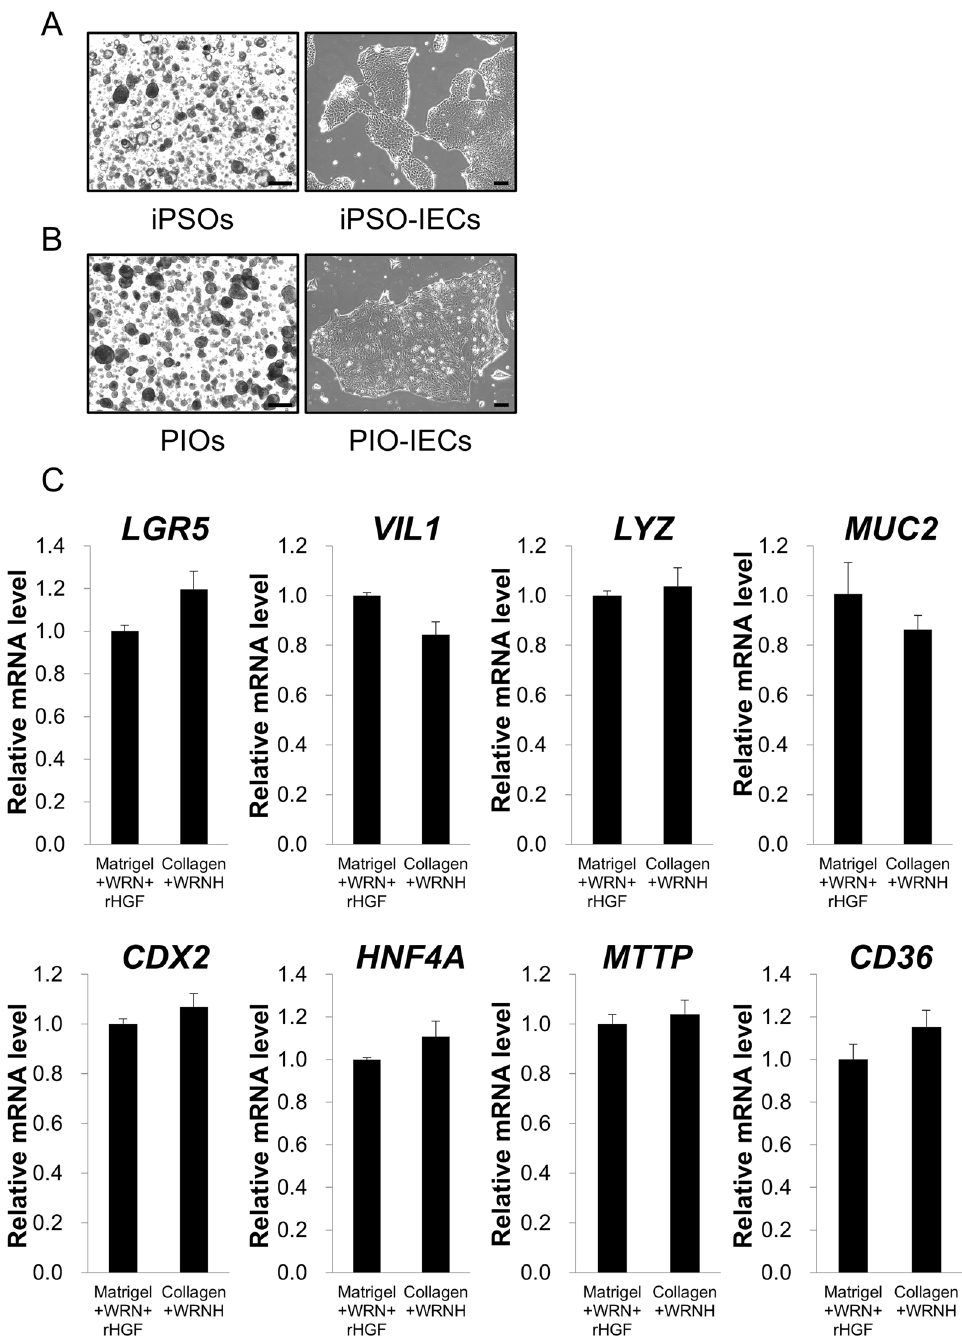
Figure 3. Development of organoid-derived monolayer IECs with WRNH CM and collagen gel. ( A, B ) After passage, hiPSOs ( A ) or hPIOs ( B ) embedded in porcine tendon type I collagen gel were cultured with growth medium containing 25% L-WRNH CM. After 5 days of culture, the cells were observed with bright-field microscopy ( left ). Scale bar, 200 μm. Subsequently, monolayered IECs were developed from either hiPSOs ( A ) or hPIOs ( B ) as described in the Methods, with growth medium containing 25% L-WRN CM, and then observed by phase-contrast microscopy ( right ). Scale bar, 100 μm. ( C ) After passage, hiPSOs embedded either in Matrigel or in porcine tendon type I collagen gel were cultured with growth medium containing 25% L-WRN CM plus 50 ng/mL recombinant HGF or 25% L-WRNH CM, respectively. After 6 days, monolayered IECs were developed from each hiPSOs and were cultured with 25% L-WRN CM plus 50 ng/mL recombinant HGF or 25% L-WRNH CM for 7 days. The cells were then harvested, and the mRNA levels of each gene were determined by qRT-PCR and normalized to 18S rRNA levels. Assays were performed in n = 3 biologically independent replicates (mean ±